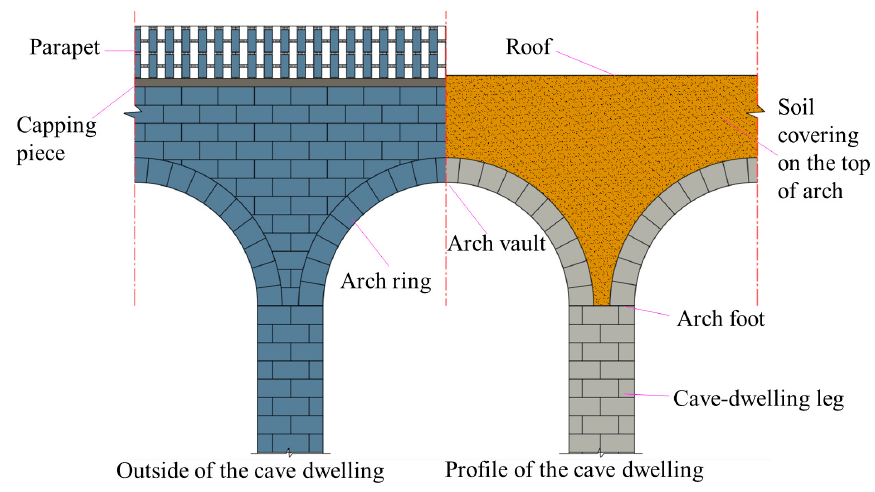
Figure 2. Construction of the masonry cave dwelling.